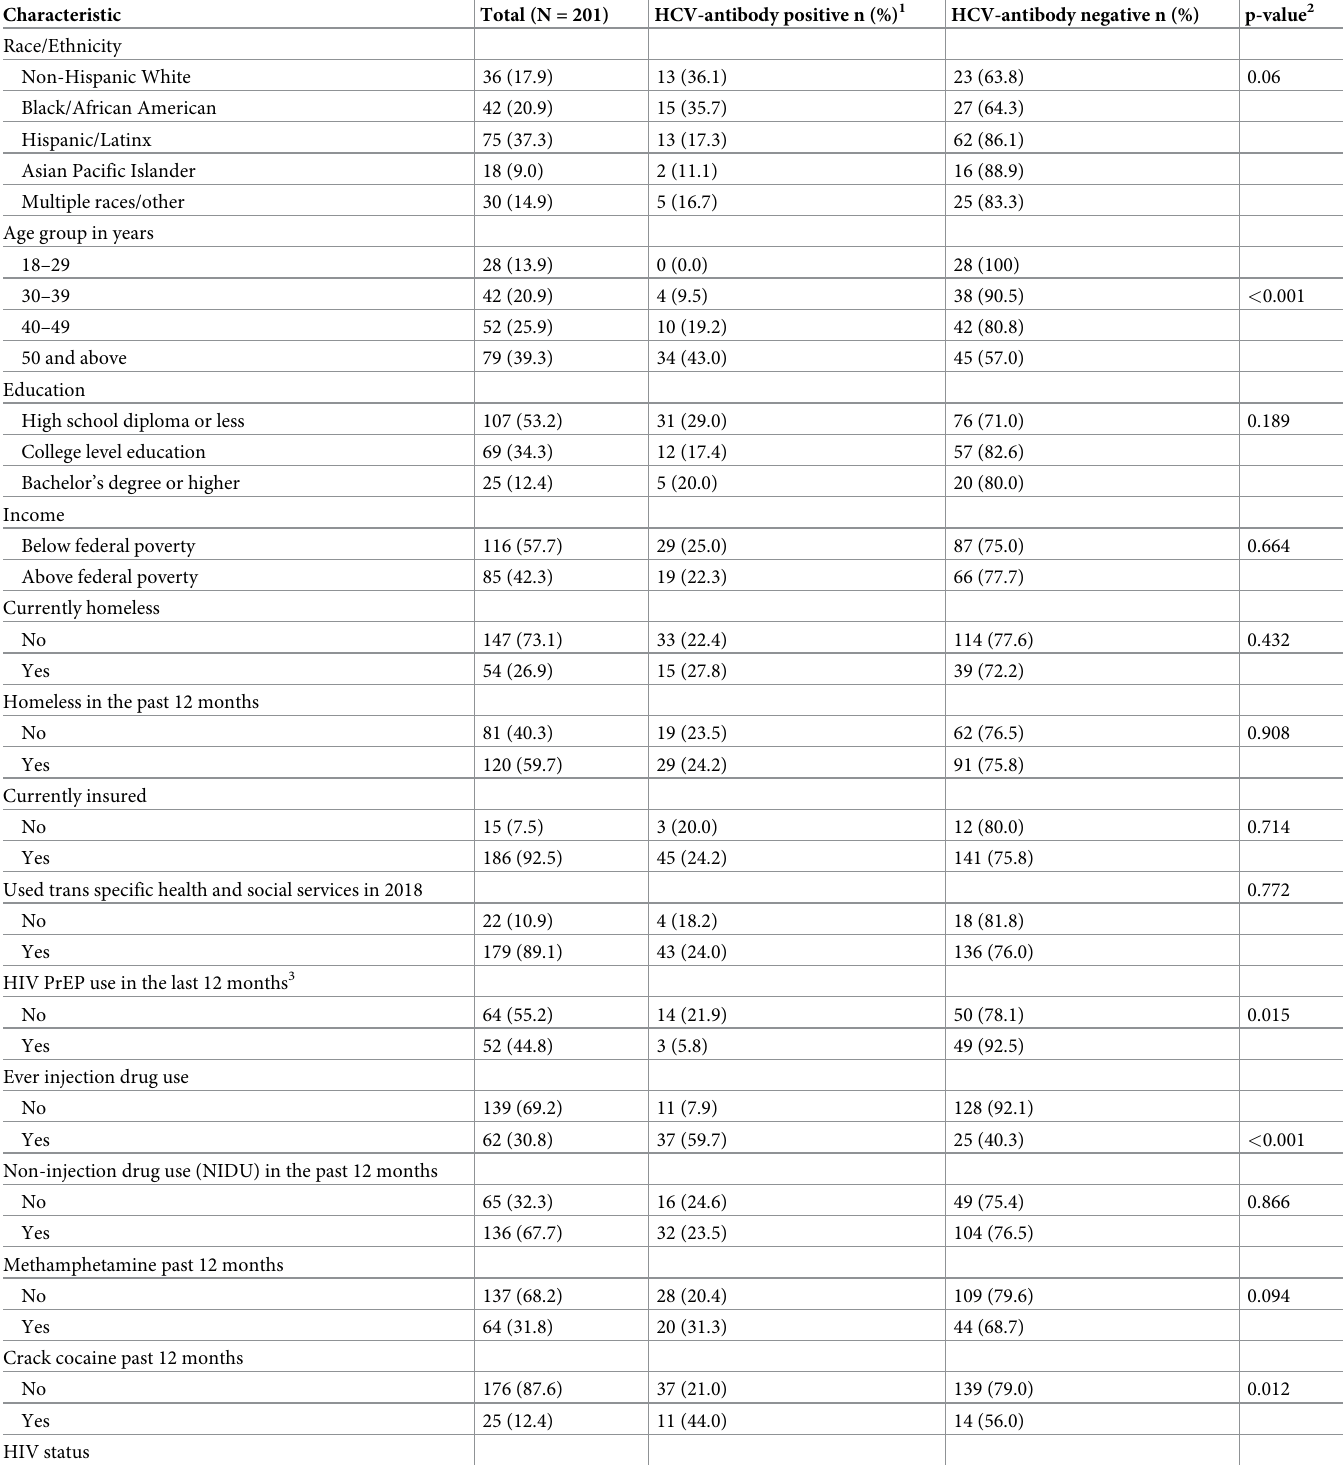
Table 1. Characteristics of trans women in the National HIV Behavioral Surveillance (NHBS) survey by hepatitis C virus (HCV) antibody status, San Francisco, CA, 2019 (N =